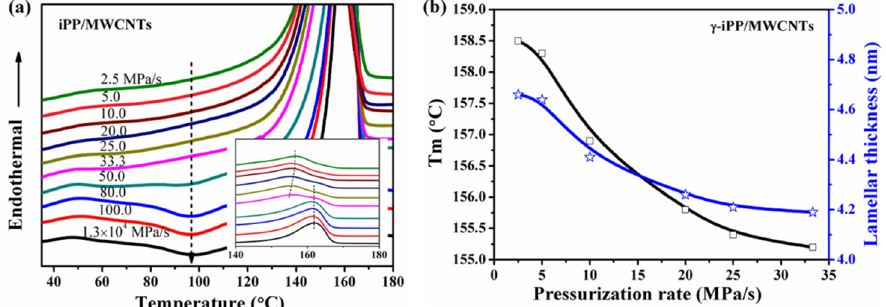
Figure 9. ( a ) DSC heating curves of iPP / MWCNTs samples obtained by pressurizing the melt to 2.0 GPa at di ff erent pressurization rate (the inset shows the melting peak region); ( b ) changes of T m and l of γ -iPP / MWCNTs samples as a function of pressurization rate.